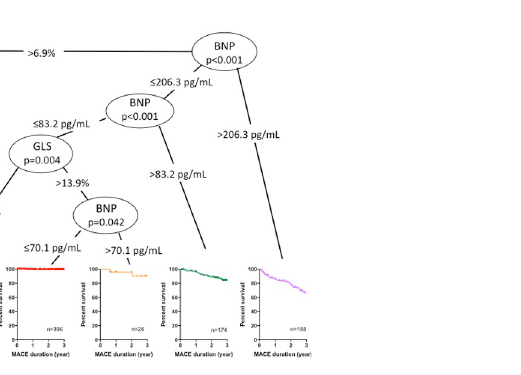
Fig 3. Optimal cut-off values of BNP and GLS, and Kaplan-Meier survival curves for predicting major adverse cardiovascular events (MACEs) in the derivation group. Survival CART analysis identified optimal BNP and GLS cut-off values to partition the risk of MACEs. Colored lines represent the survival curve for MACEs in each subset, classified using BNP and GLS cut-off values. BNP; B-type natriuretic peptide, GLS; global longitudinal strain, CART; classification and regression trees.